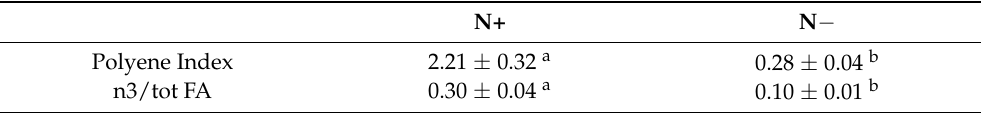
Table 3. Unsaturation markers calculated from the fatty acid profile of P. tricornutum cultivated for 15 days under standard (N+) and starvation condition (N −